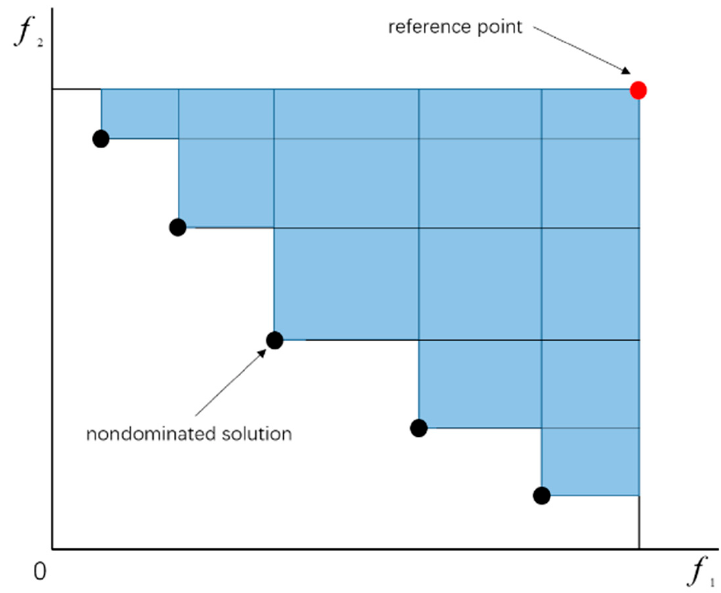
Figure 6. Diagram of the hypervolume ( HV ). Table 4. Experimental parameter settings for the co-evolutionary NSGA-III (NSGA-III-COE) per- formance evaluation.